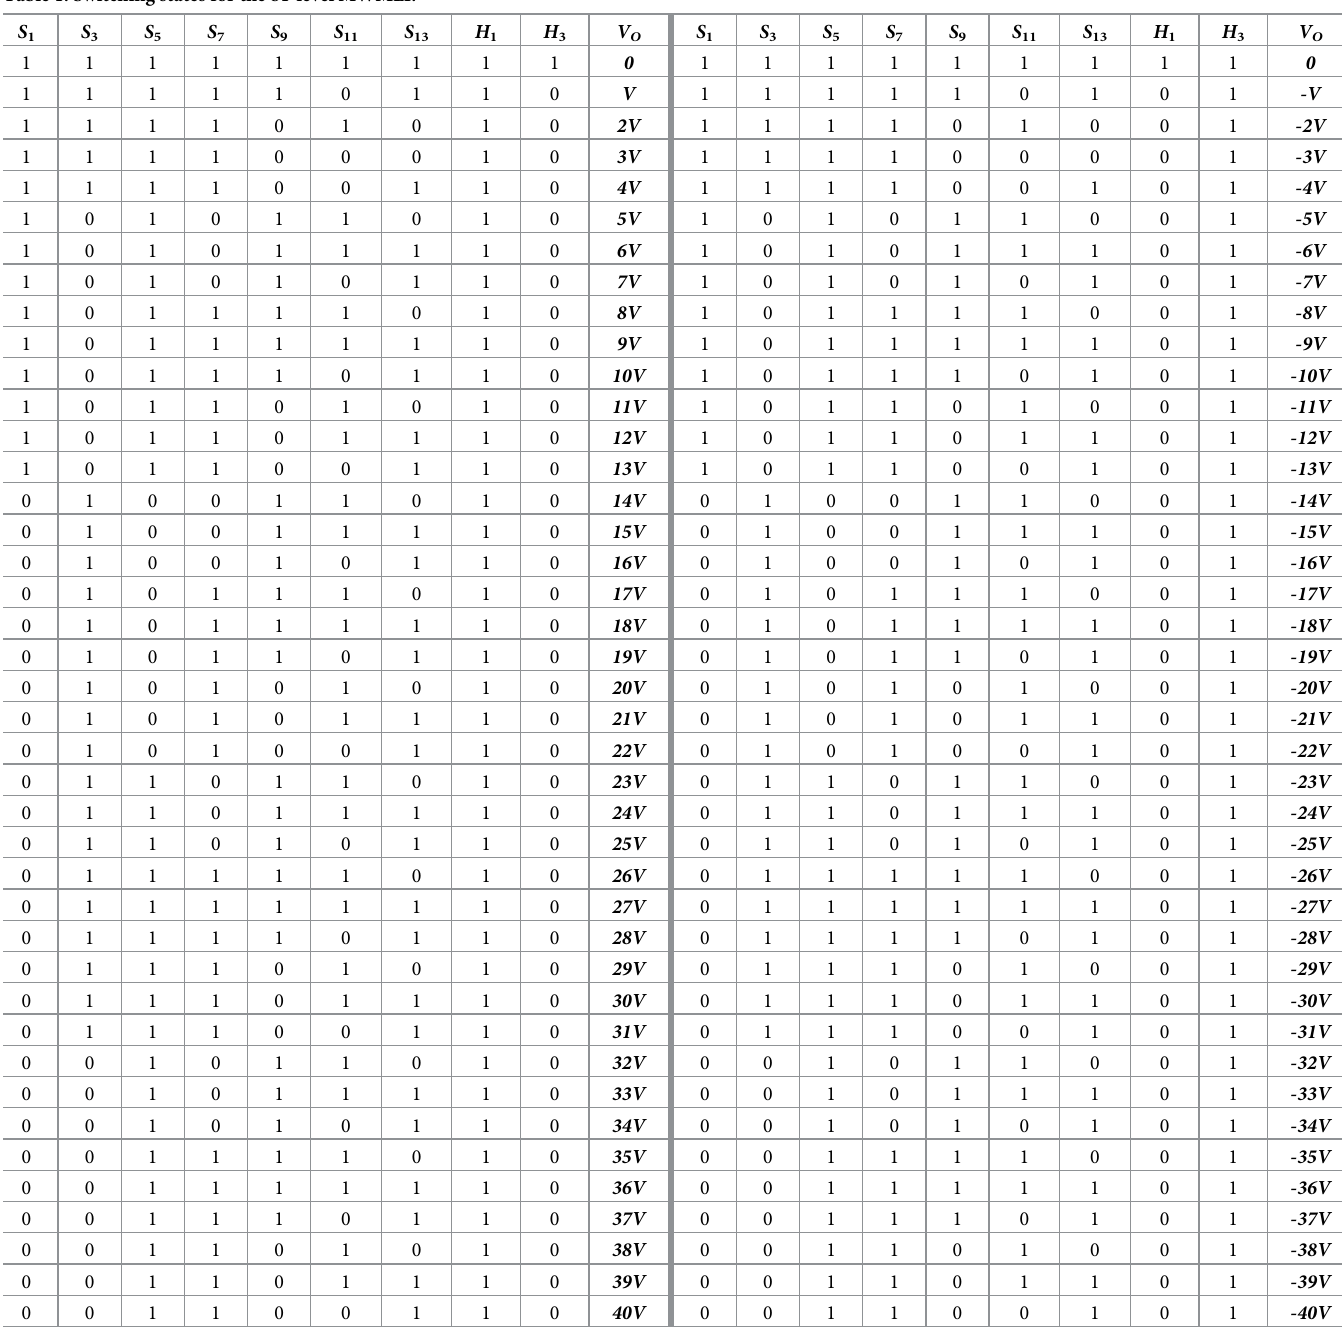
Table 1. Switching states for the 81-level